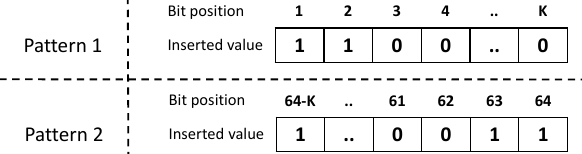
Figure 14. Two pattern examples that might be added to the obfuscated challenge.